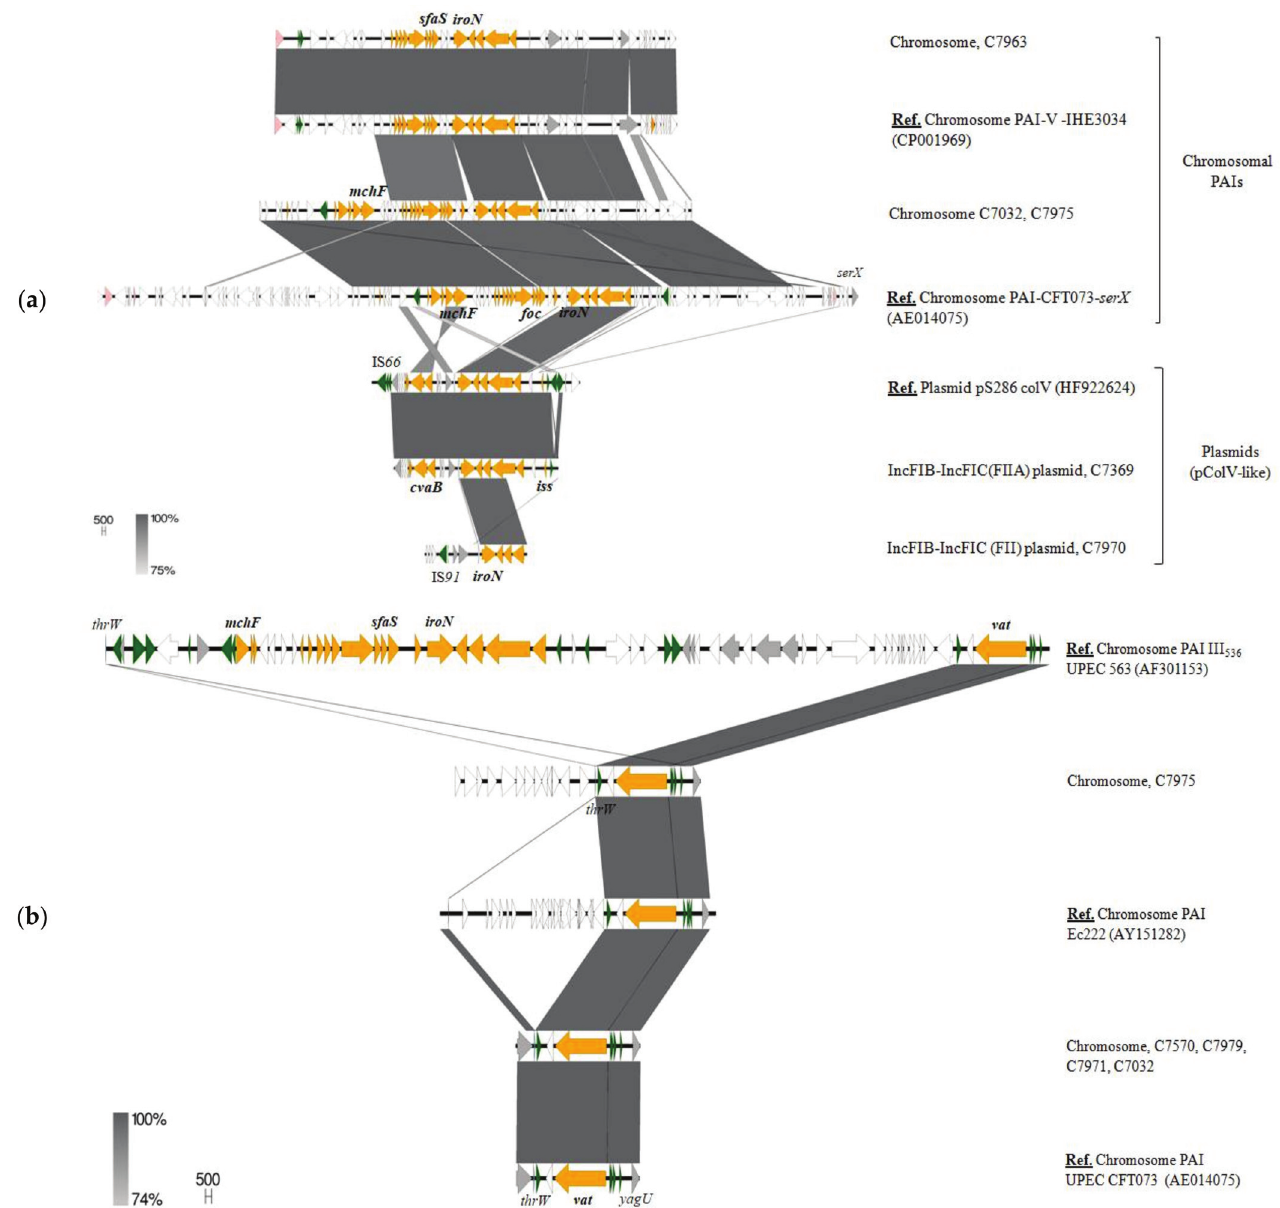
Figure 6. Genetic location and surrounding of iroN ( a ) and vat ( b ) virulence genes in some of the E. coli strains from our col- lection. The reference genomes used for BLASTn comparisons are indicated as “Ref. Genetic location-Strain name-(accession number)”. Genes are colored according to their function: orange, virulence genes; green, recombination/transposition; pink, prophage genes; grey, known function; white, unknown